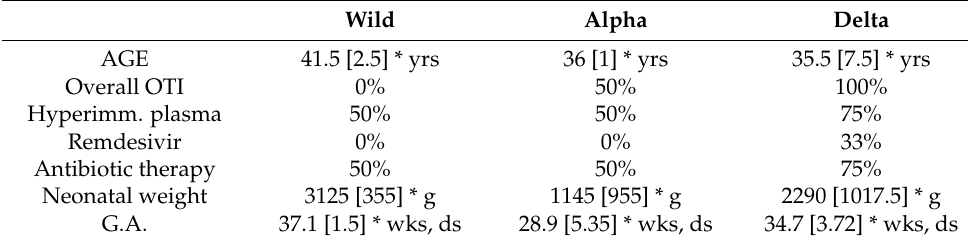
Table 3. Different maternal and obstetrical outcomes based on the SARS-CoV2